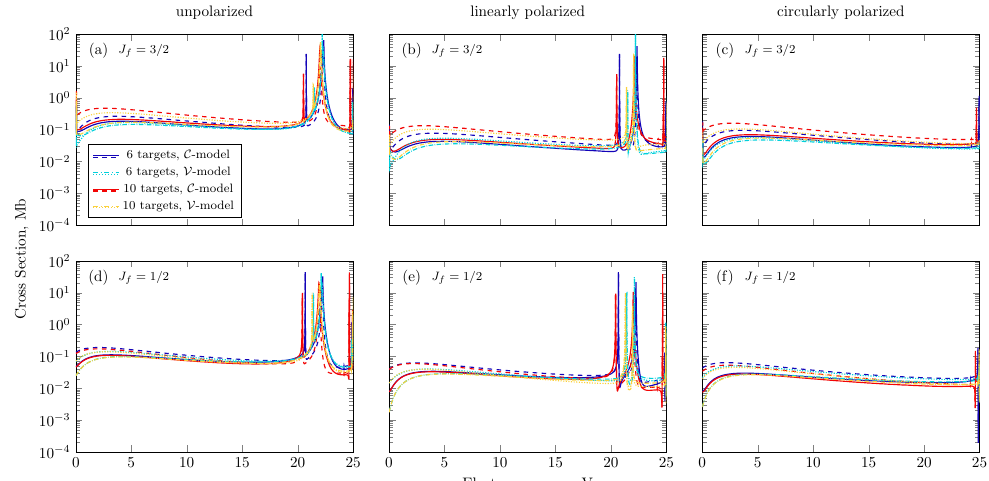
Figure 3. Cross-section calculated within the V - (dash-dotted lines correspond to length gauge, dotted lines to velocity gauge) and C - (solid lines correspond to length gauge, dashed lines to velocity gauge) models with six (cyan and blue) and ten (orange and red) target states for ionization of 2 s 2 2 p 5 ( 2 P 3/2 ) 3 s [ 3/2 ] 1 state to 2 s 2 2 p 5 ( 2 P 3/2 ) (upper row) and 2 s 2 2 p 5 ( 2 P 1/2 ) (bottom row) ionic states for unpolarized ( a , d ), linearly polarized ( b , e ) and circularly polarized ( c , f ) fields.